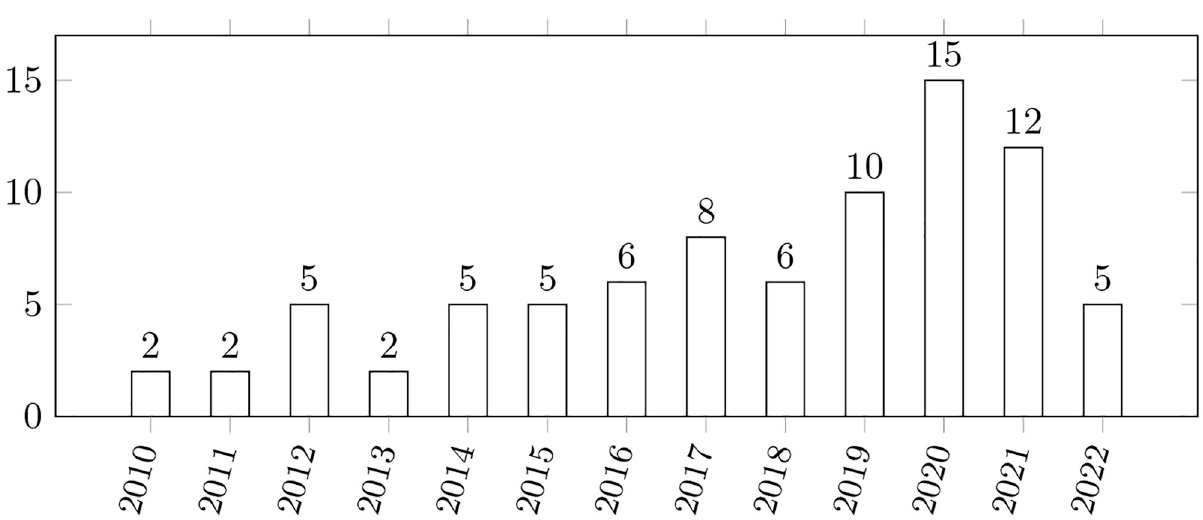
Fig 7. Papers distribution by years. The bars show the number of papers published on the topic between 2010 and 2021. No papers we found for the period 2006–2009. 2006 was the starting year for our SLR IC3.